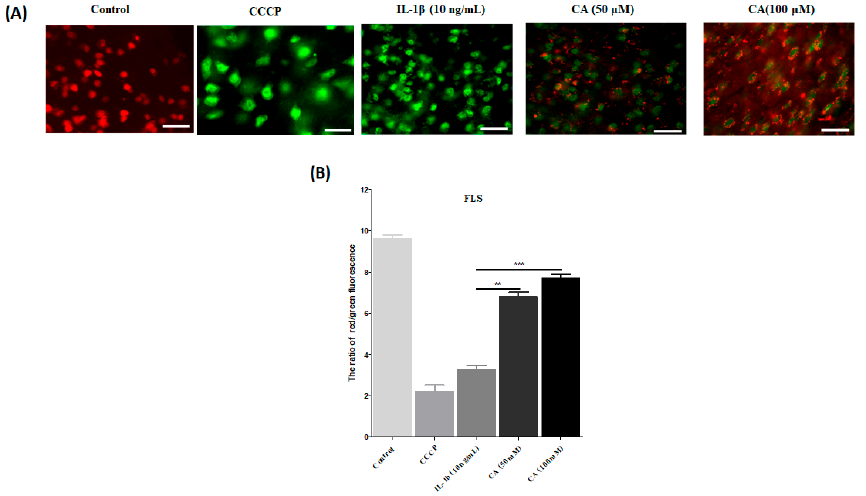
Figure 10. The antioxidant capacity of CA was checked in FLS by the JC-1 staining assay. ( A ) A fluorescence microscope was used to examine MMP ( ∆Ψ m) in FLS cells exposed to CCCP (positive control), IL-1 β (10 ng/mL), CA (50 and 100 µ M) for 24 h and stained with JC-1 reagent to check the fluorescence, scale bar = 100 µ M. ( B ) Quantitative analysis of the red to green fluorescence intensity ratio, with data expressed as mean ± S.D., ** p < 0.01, and *** p < 0.001.